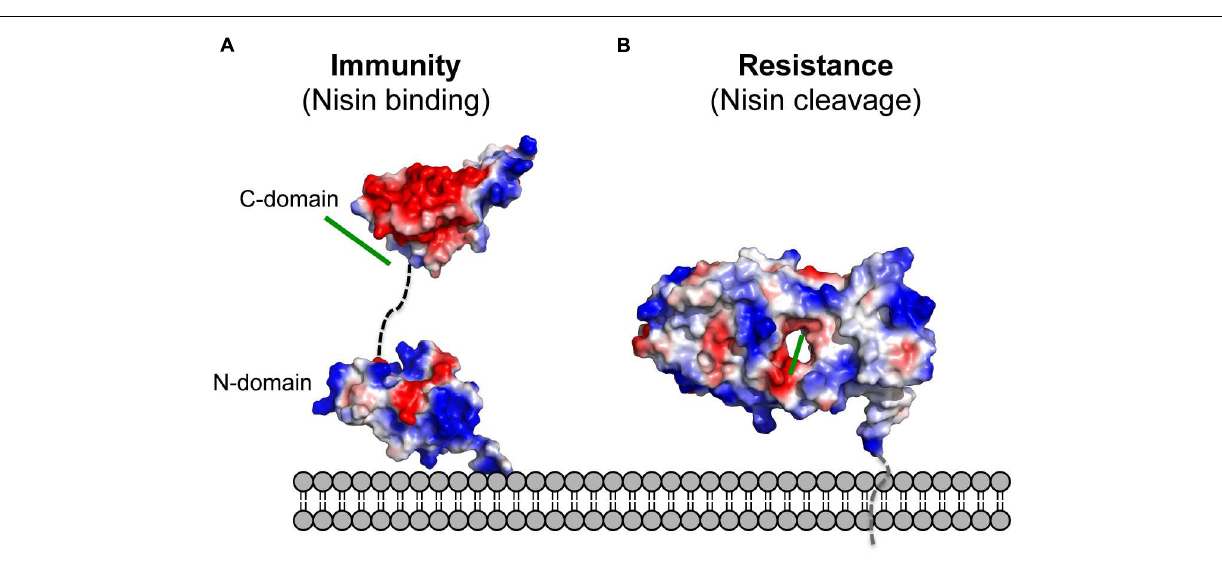
Frontiers in Microbiology |